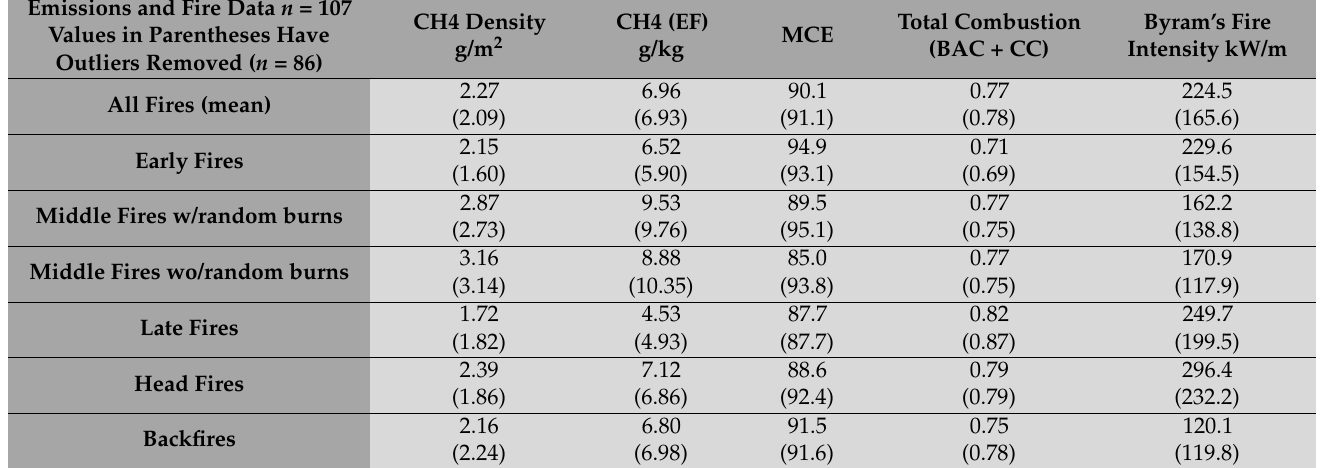
Table 2. Methane Emission Parameters and Key Fire Metrics by Fire Season and Type for All Fires in Tabou and Faradiele, Mali, 2015–2016 (EF is emission factor, MCE is modified combustion efficiency, BAC is burned area completeness, CC is combustion completeness, and kW/m is kilowatts per